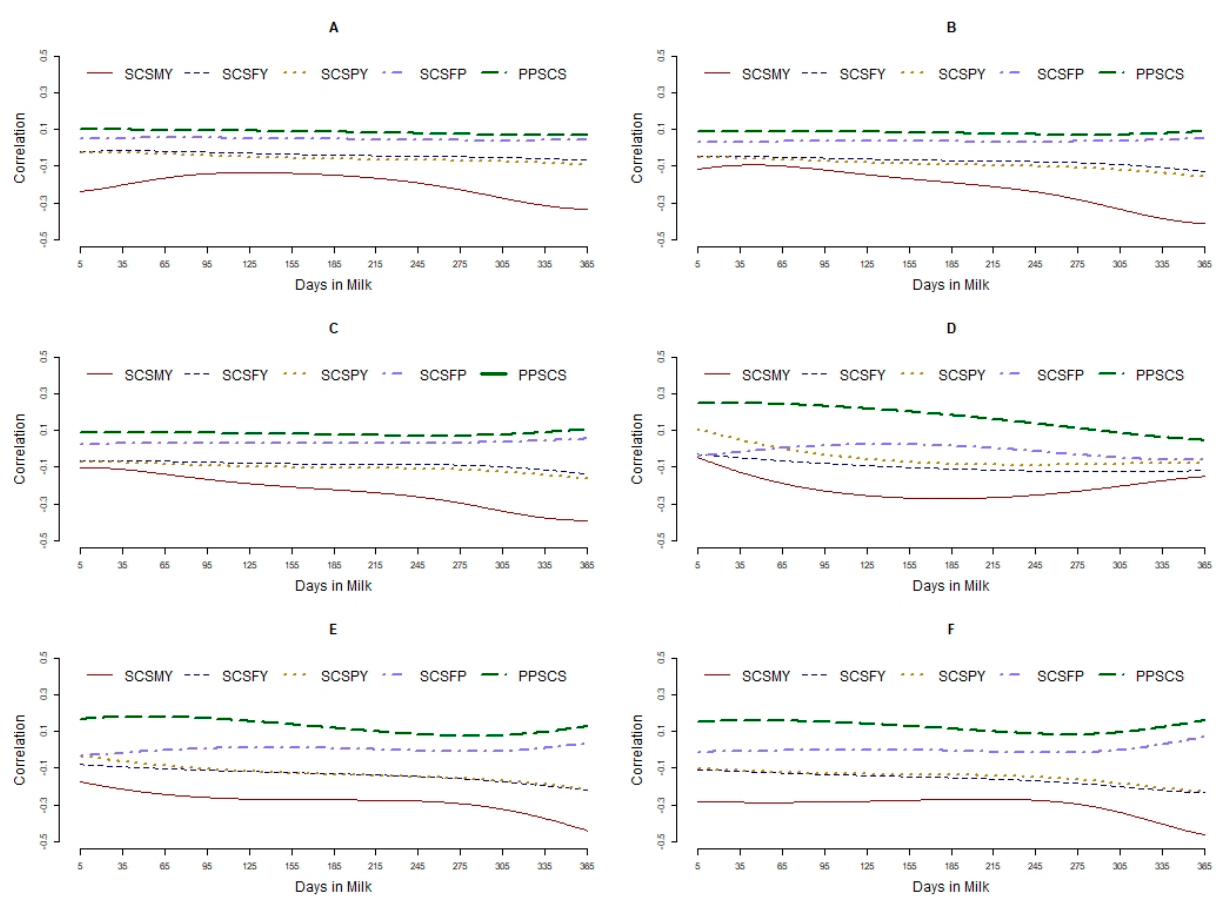
Figure 3. Phenotypic and genetic correlations estimated between SCS and productive traits over days in milk in the first three parities. Phenotypic correlation in the first parity ( A ), second parity ( B ), and third parity ( C ). Genetic correlation in the first parity ( D ), second parity ( E ), and third parity ( F ). SCSMY, SCSFY, SCSPY, SCSFP, and SCSPP, are abbreviations for somatic cell score and milk yield (SCSMY), fat yield (SCSFY), protein yield (SCSPY), fat percentage (SCSFP), and protein percentage (SCSPP), respectively.